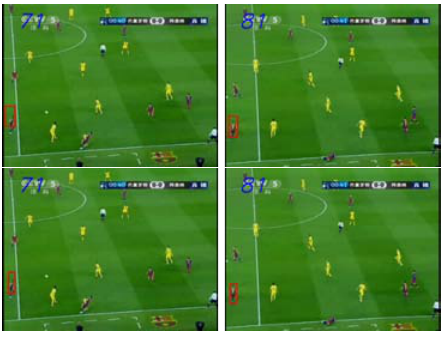
Fig. 2. Comparison between the CHOG algorithm and model update CHOG algorithm, the above results are CHOG and the bellows are model update CHOG